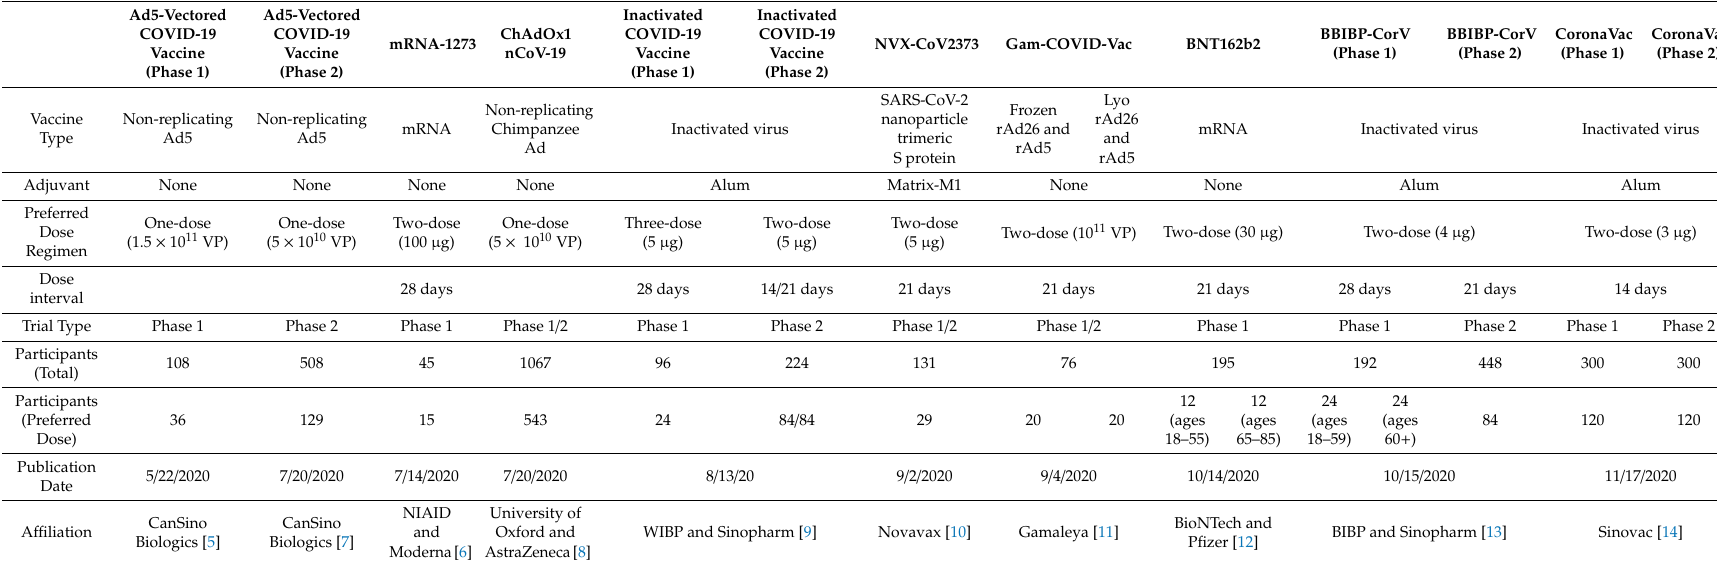
Table 1. Characteristics of COVID-19 vaccine candidates and phase 1 or 2 clinical